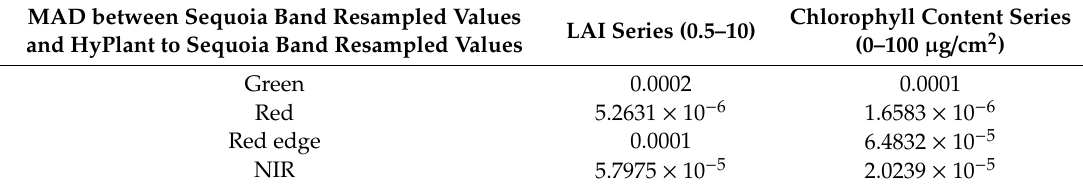
Figure A1. Simulated Sequoia and Sentinel 2A derived NDVI and CHL values for simulations of varying LAI and Chlorophyll a + b content respectively. Table A1. Errors due to spectral sampling interval of the HyPlant bands spectrally resampled to simulate Sequoia data, assessed per band for a PROSAIL simulated series of leaf area index (LAI) and chlorophyll content of a maize-like canopy.